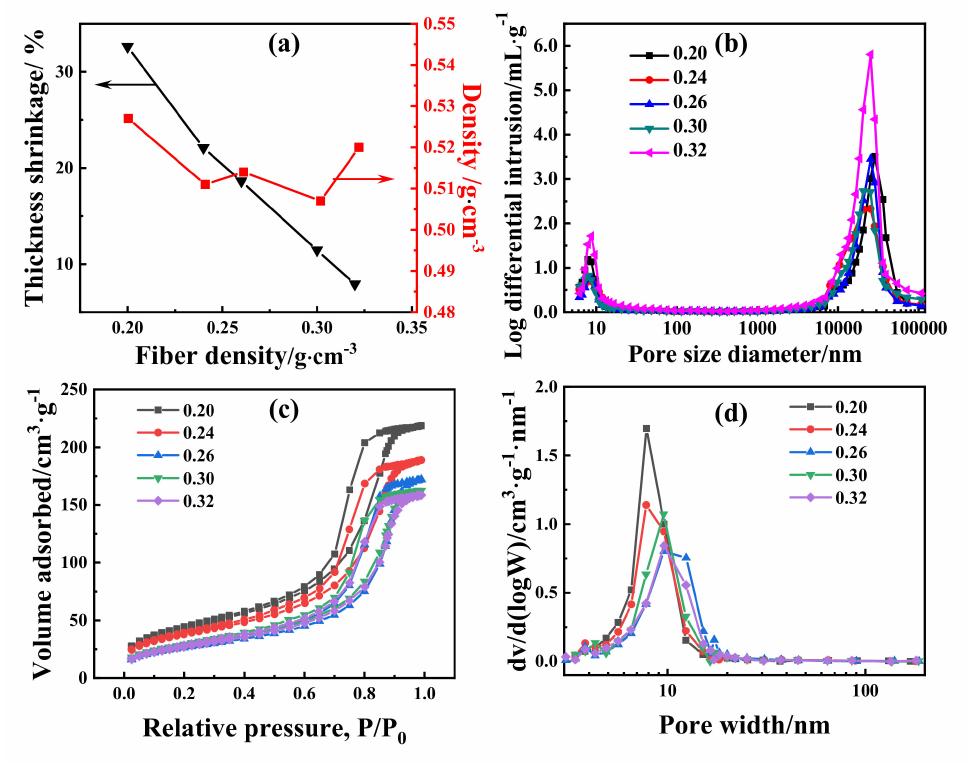
Figure 2. ( a ) Density and thickness shrinkage, ( b ) MIP pore size distribution, ( c ) NS isotherms, and ( d ) NS pore size distribution of